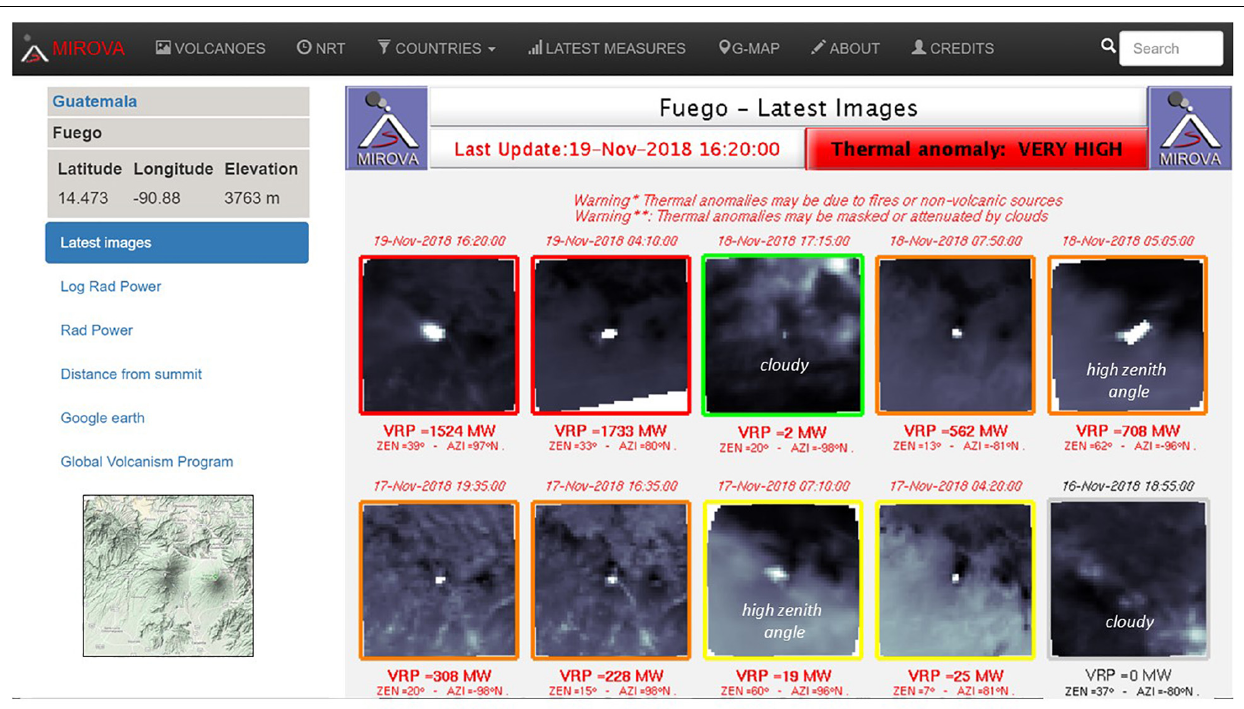
FIGURE 2 | Snapshot of the Latest IR Images display posted on MIROVA website for the Fuego volcano, Guatemala (accessed on 19 November 2018).